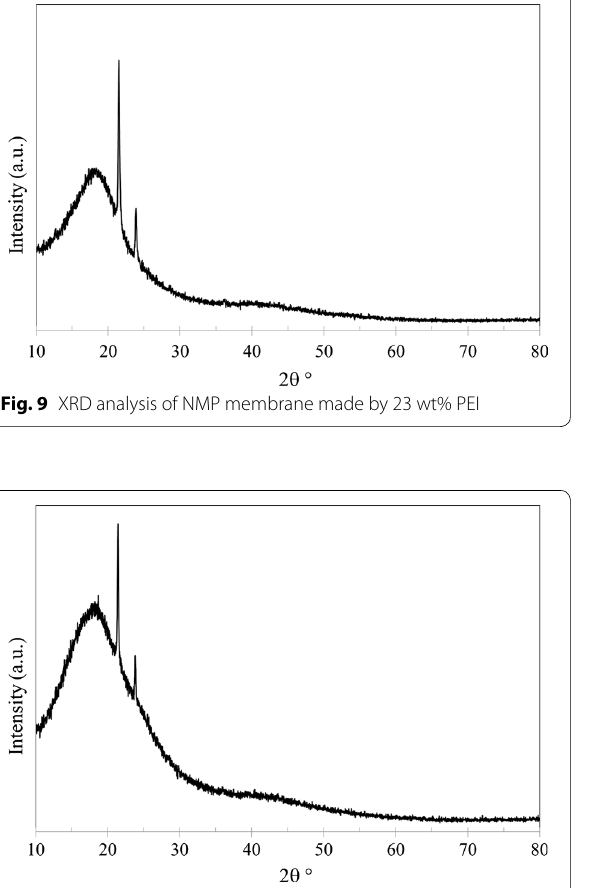
Fig. 10 XRD analysis of NMP membrane made by 27 wt% PEI